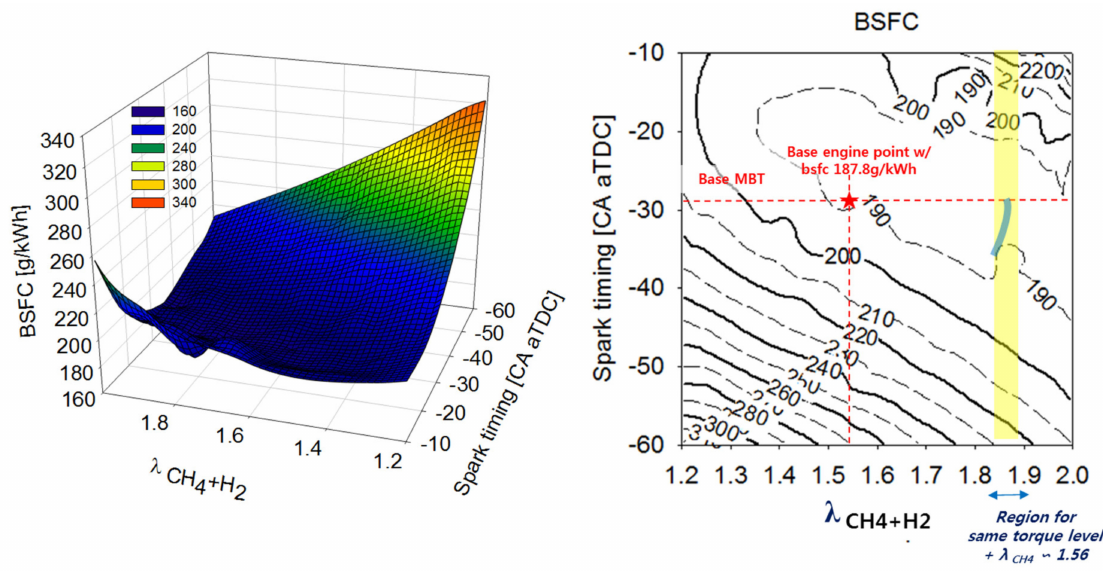
Figure 9. Response surface model: brake specific fuel consumption as functions of spark timing and hydrogen added methane based EAR @1300 rpm.